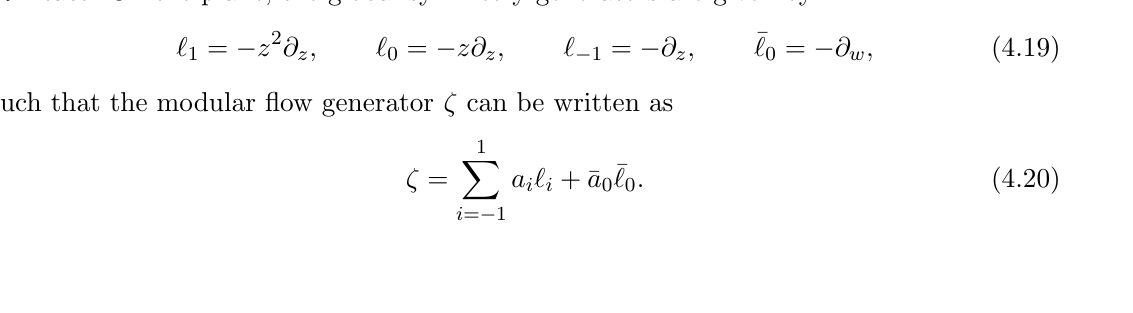
= 0. The interval 6 is shown in gray. The modular (cid:13)ow (4.27) D